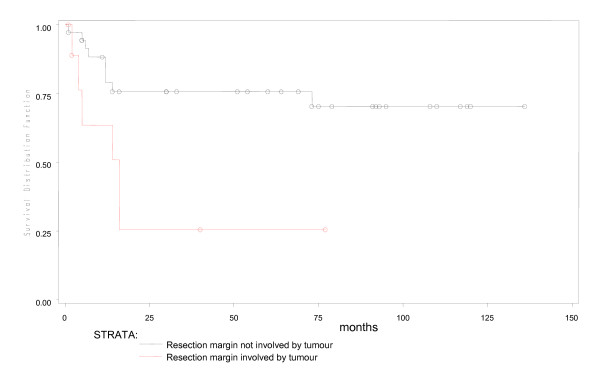
Involvement of the resection margin by microscopic tumour and overall survival.